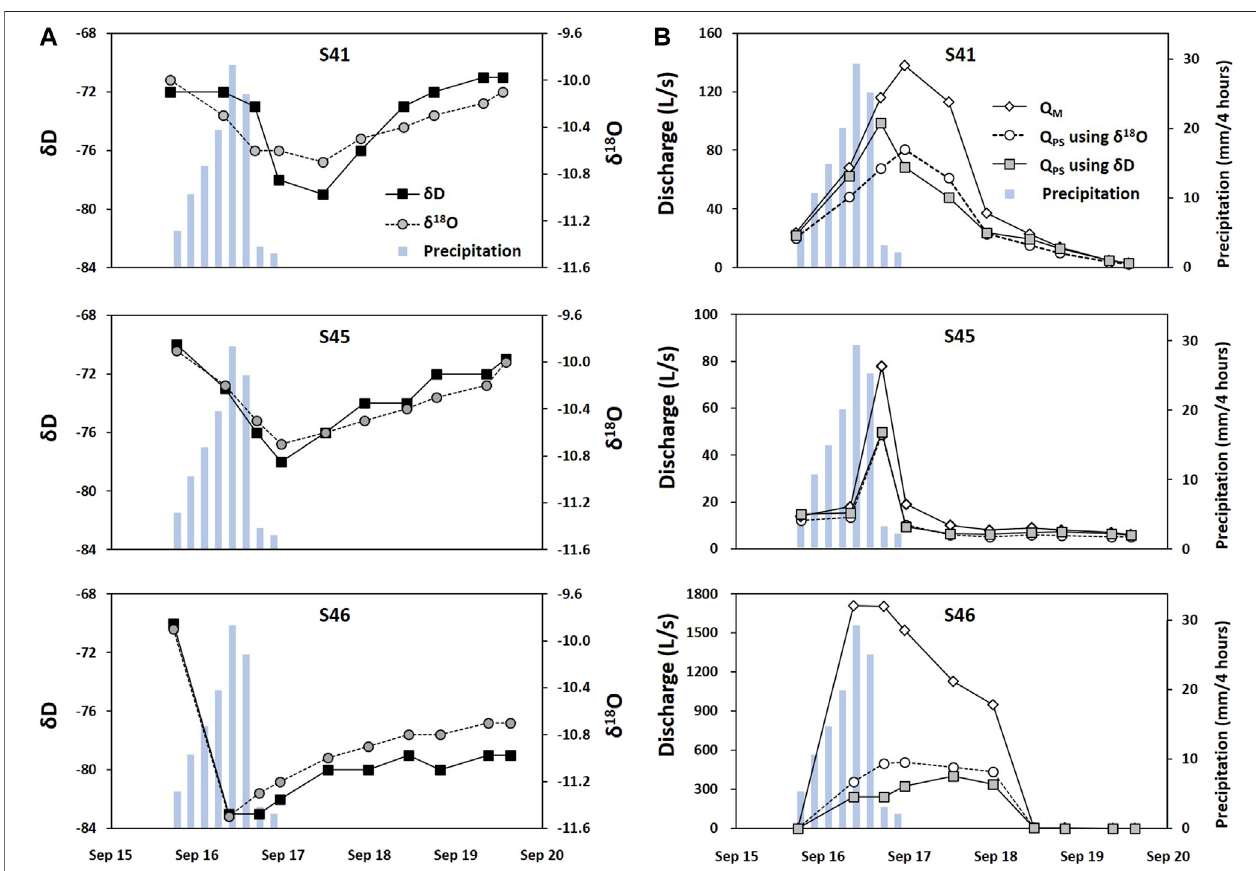
FIGURE 11 | Isotropic variations (A) and hydrograph separation (B) at three Type Ⅱ springs during the typhoon in Figure 2B . The blue bar indicates precipitation.